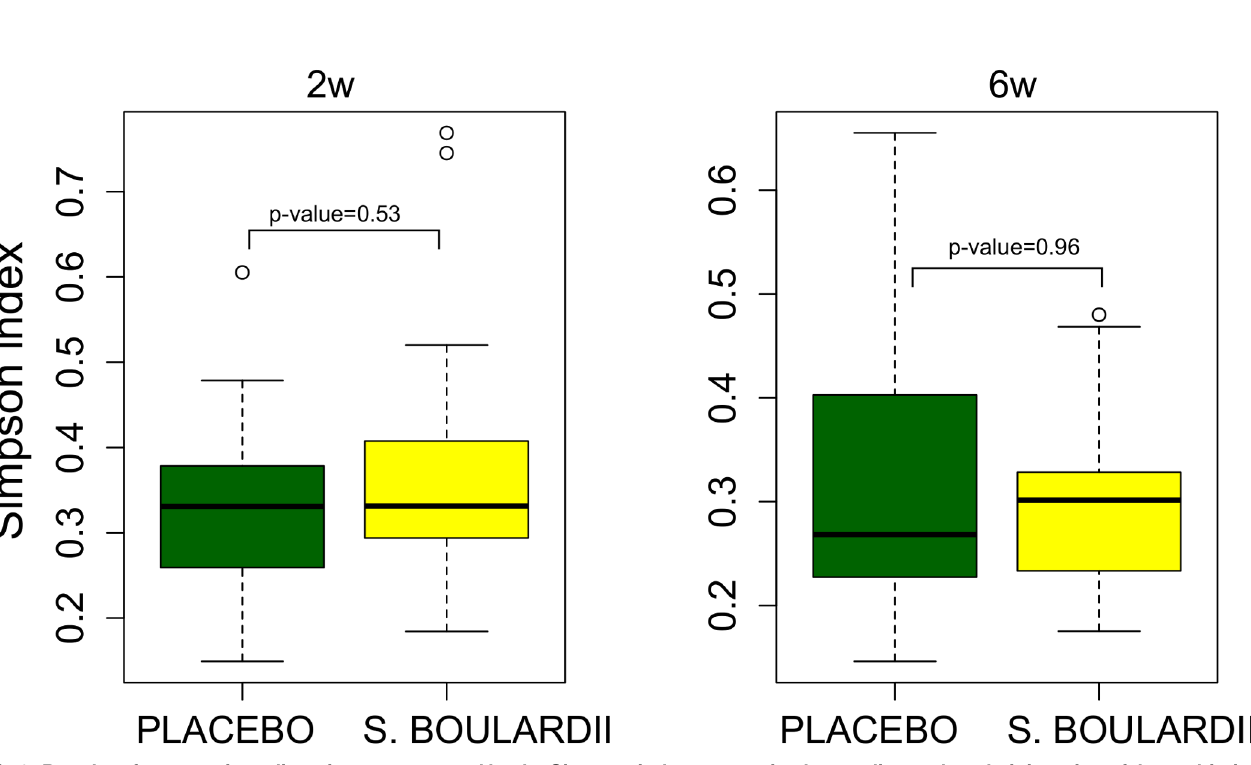
PLOS ONE | DOI:10.1371/journal.pone.0150306 February 26,